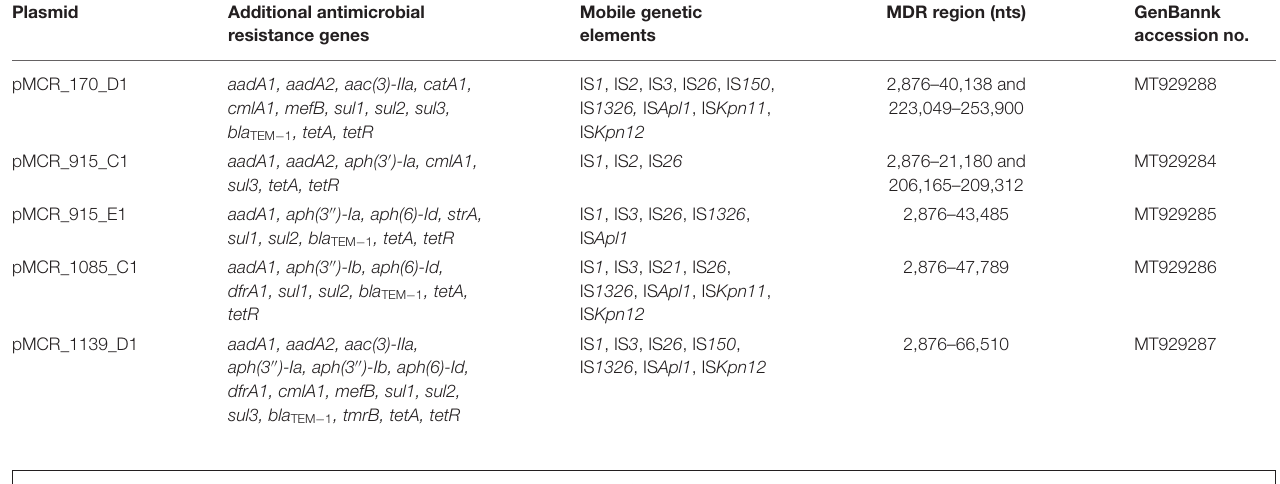
Mobile genetic elements